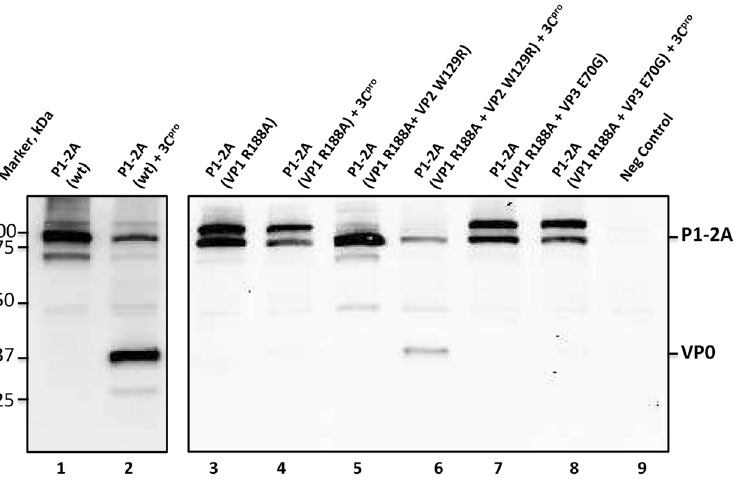
Figure 3. A second site substitution within VP2 compensates for the deleterious effect of the VP1 R188A modification in the FMDV P1-2A capsid precursor. Plasmids encoding wt or mutant forms of the FMDV P1-2A (as indicated) were expressed alone (odd numbered lanes) or with the FMDV 3C pro (even numbered lanes) within BHK cells, as described in Methods section. Cell lysates were analyzed by SDS-PAGE and immunoblotting using guinea pig anti-FMDV O-Man antisera. Bound antibodies were visualized using the anti-guinea pig HRP-conjugated secondary antibodies and a chemiluminescence detection kit. The unprocessed P1-2A precursor and the VP0 processing product are indicated. Note the enhanced processing of the P1-2A (VP1 R188A) mutant in the presence of the substitution VP2